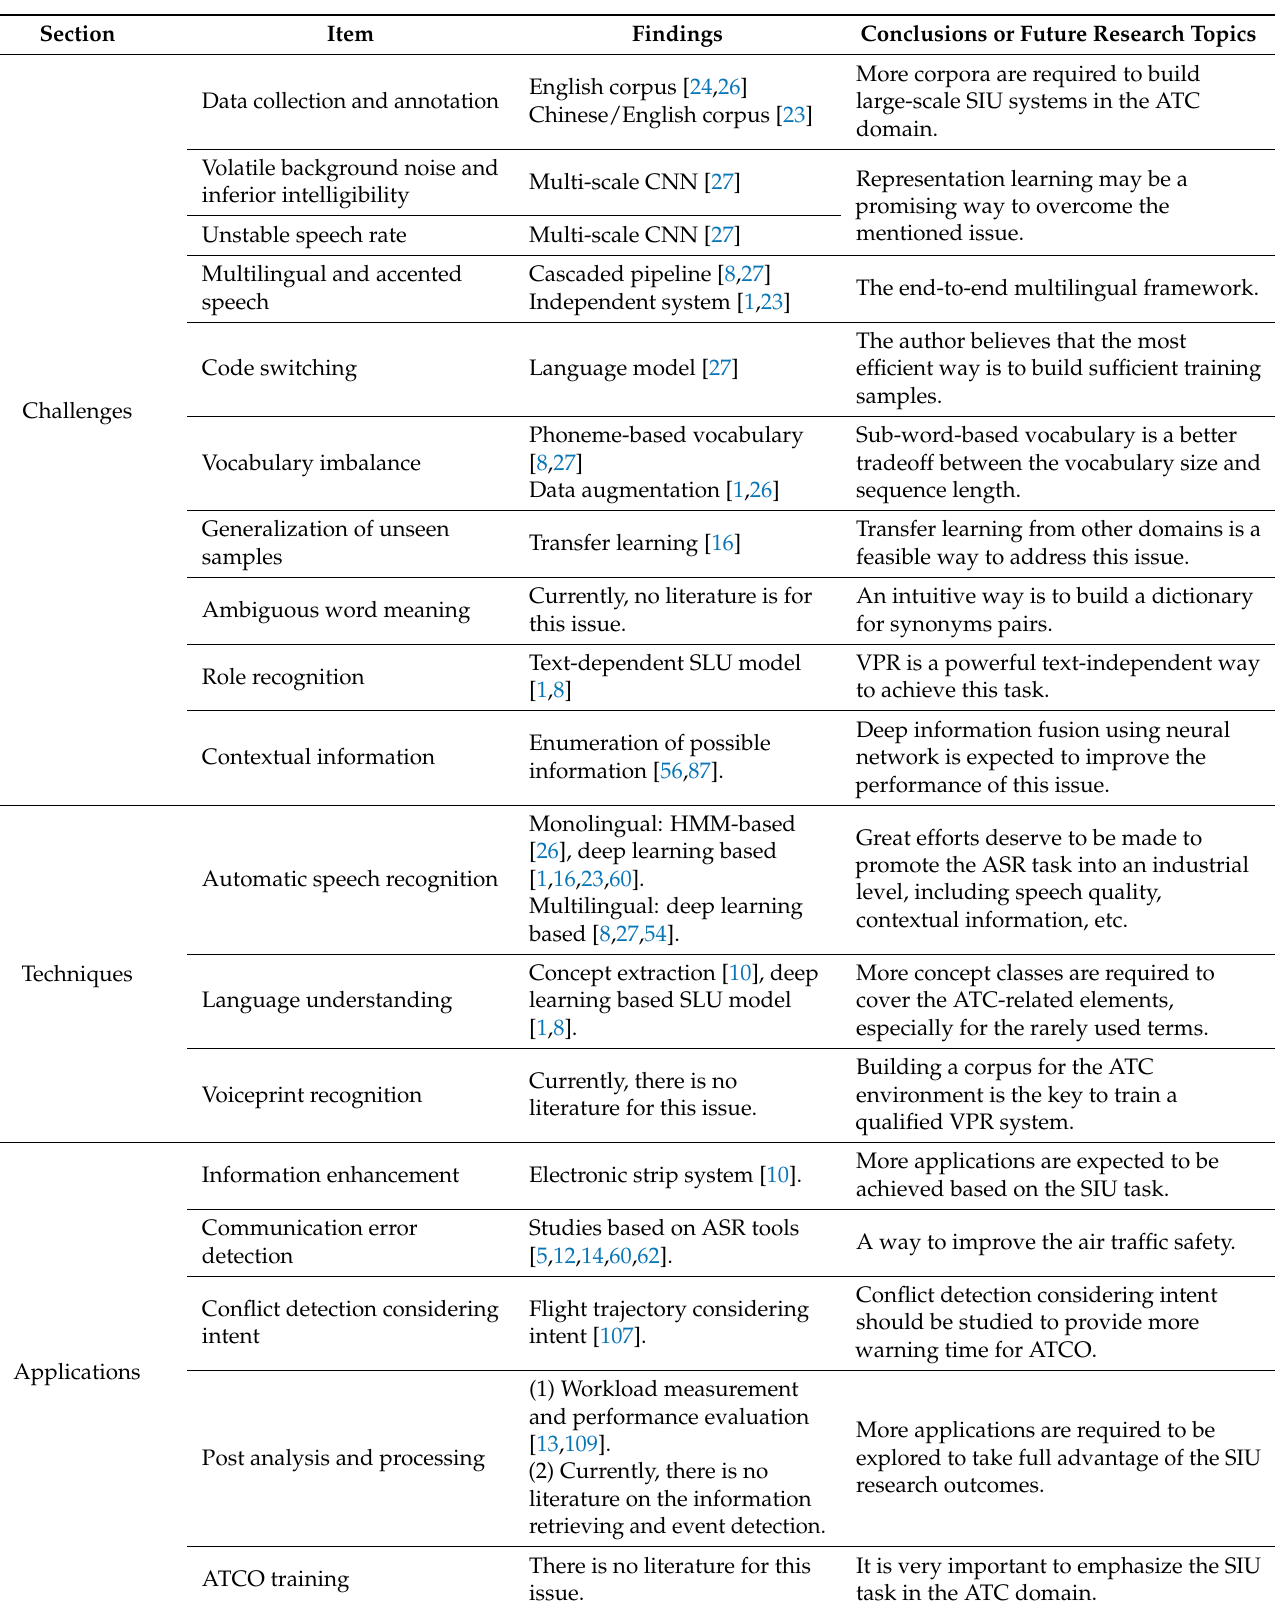
Table 7. A summary of this